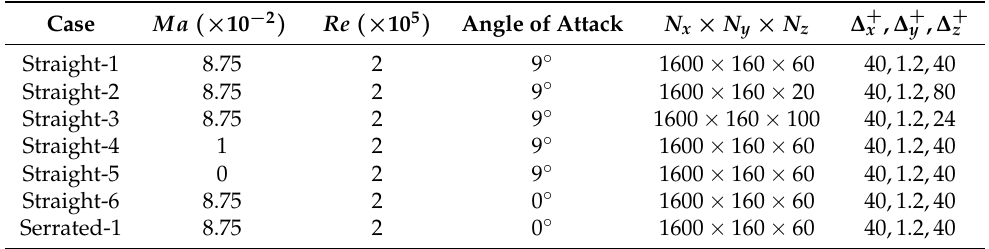
Table 1. Computational